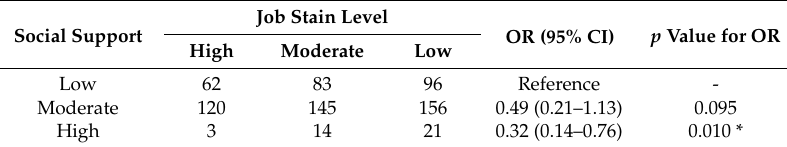
Table 3. Association between job strain and social support.